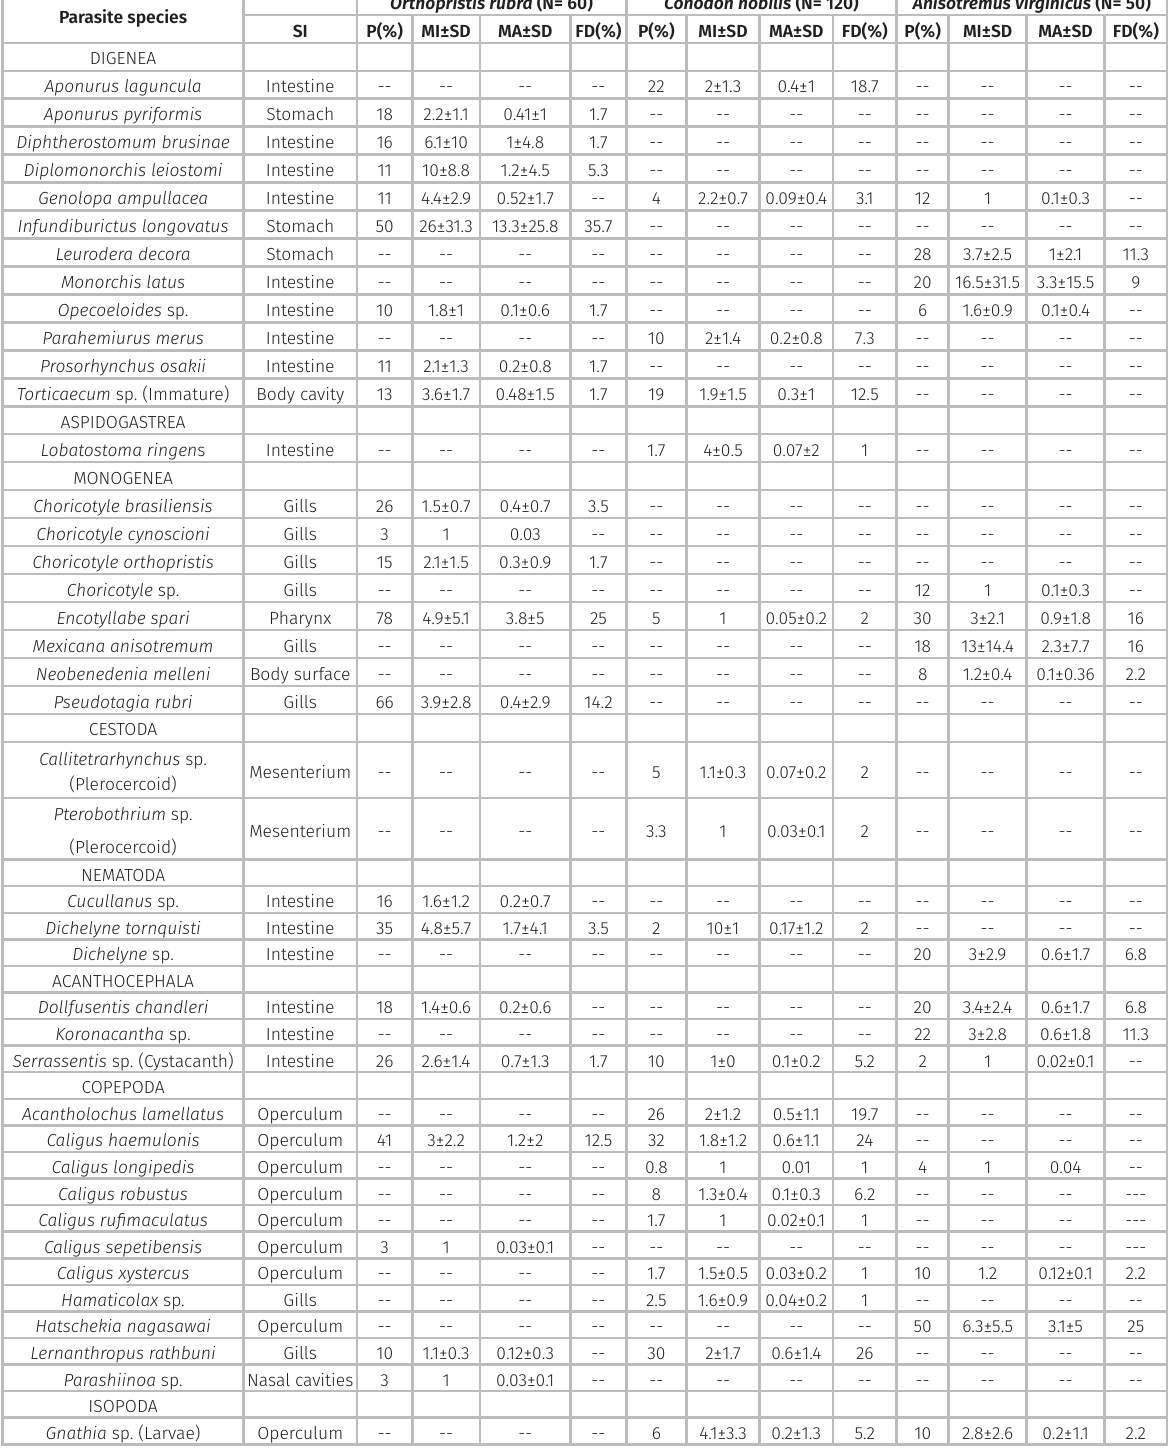
Table I. Site of infection (SI), prevalence (P%), mean intensity (MI), mean abundance (MA) and frequency of dominance (FD%) of metazoan parasites of Anisotremus virginicus, Conodon nobilis and Orthopristis rubra from the coastal zone of Rio de Janeiro,